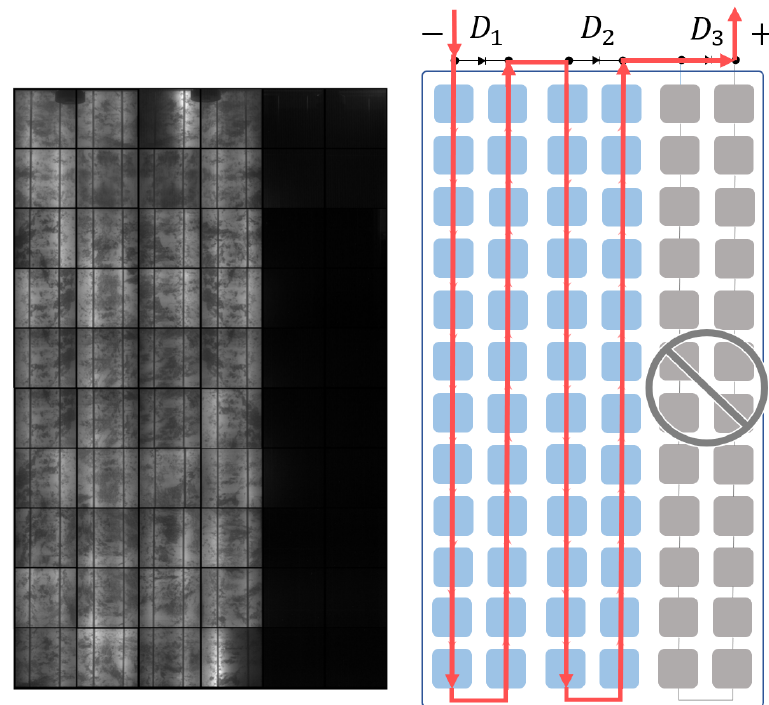
Figure 7. EL image and current flow of RSB hotspot module (240B).